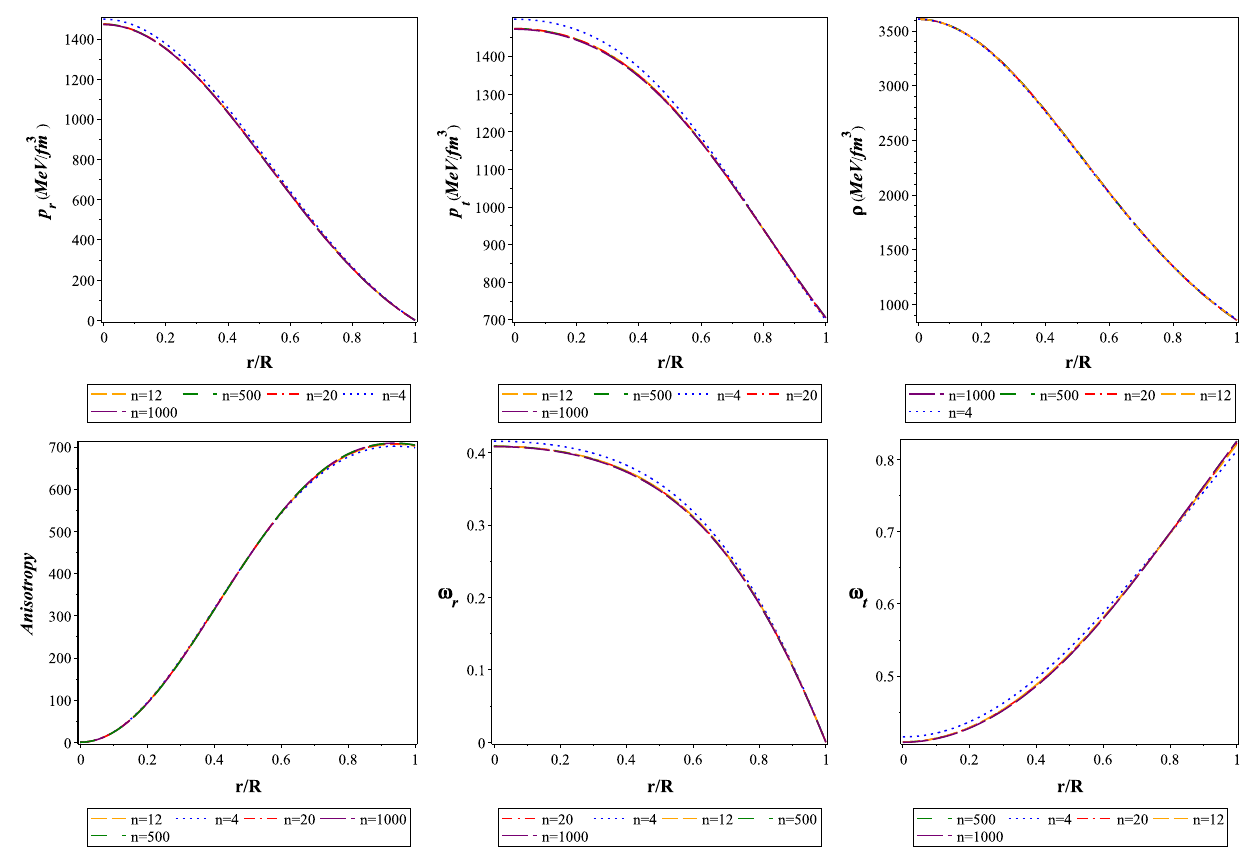
Fig. 2 Variation of the radial pressure p r (top left), tangential pressure p t (topmiddle),energydensity ρ (topright),anisotropy (cid:8) (bottomleft), radial pressure-density ratio, ω r = p r /ρ (bottom middle), and tangen- tial pressure-density ratio ω r = p r /ρ (bottom right) with respect to the